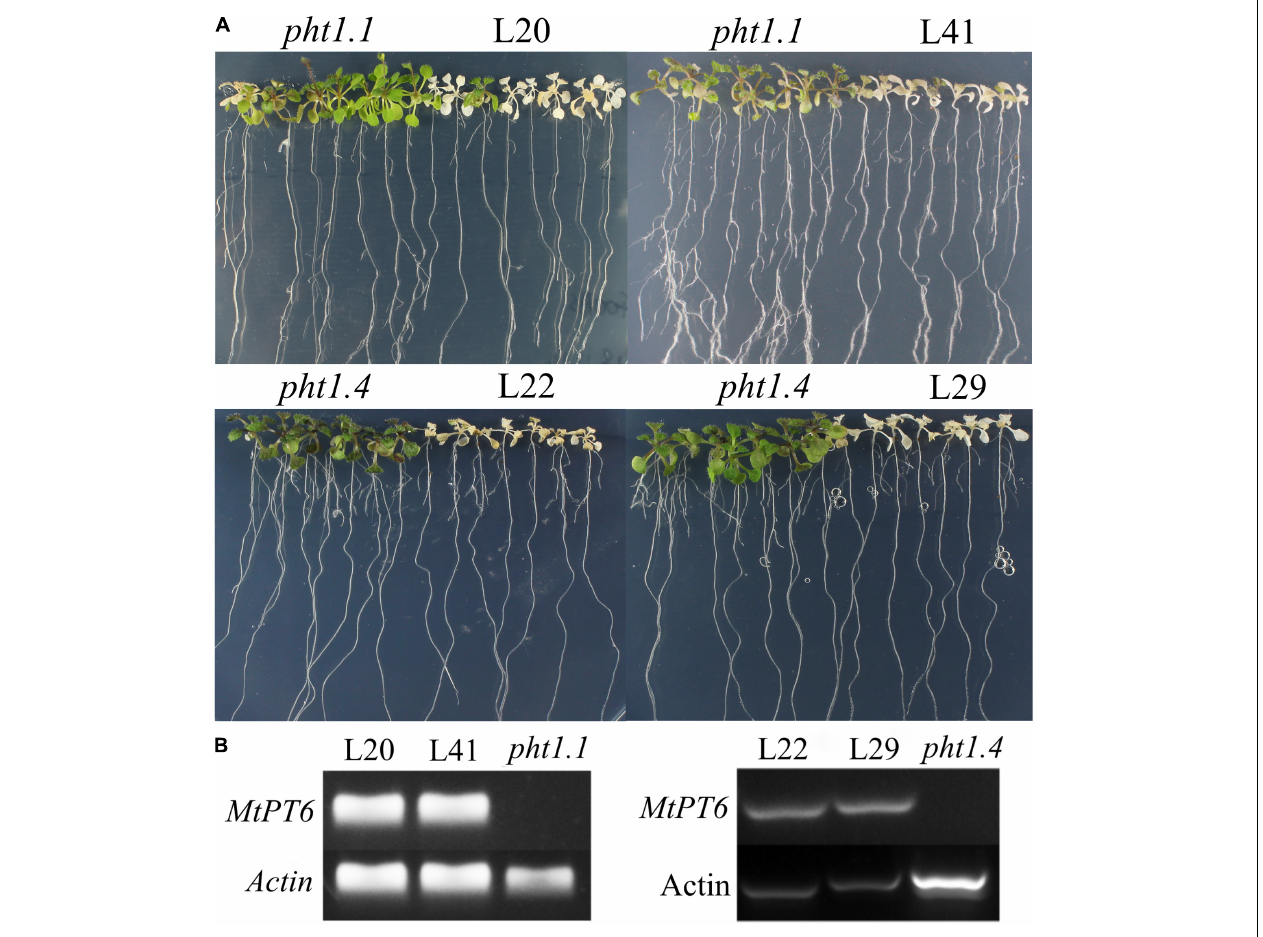
FIGURE 5 | Phenotype of tolerance to arsenate treatment in different plants. (A) Phenotype identification of transgenic plants. (B) Identification of transgenic plants by PCR. Pht1.1 and pht1.4 are Arabidopsis knockout mutants; L20 and L41 are complemented pht1.1 with MtPT6 ; L22 and L29 are complemented pht1.4 with MtPT6 . Pht1.1 and pht1.4 transgenic lines were treated with 400 and 300 µ M As, respectively.